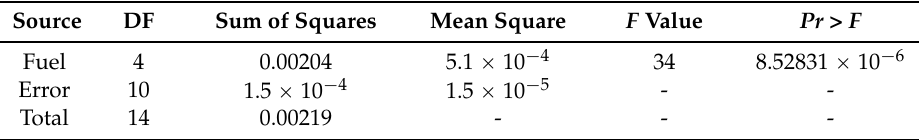
Table 6. ANOVA for the acid value.